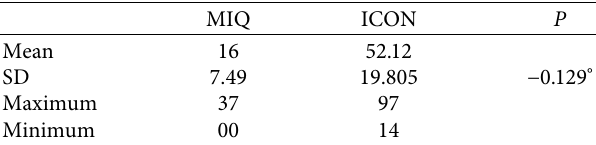
Table 8: Correlation between the different scores of the MIQ and the one of the